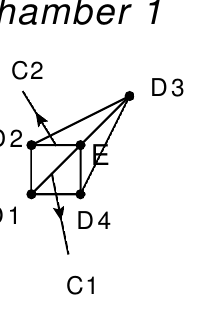
Figure 8 . Two resolutions of toric diagram C in figure